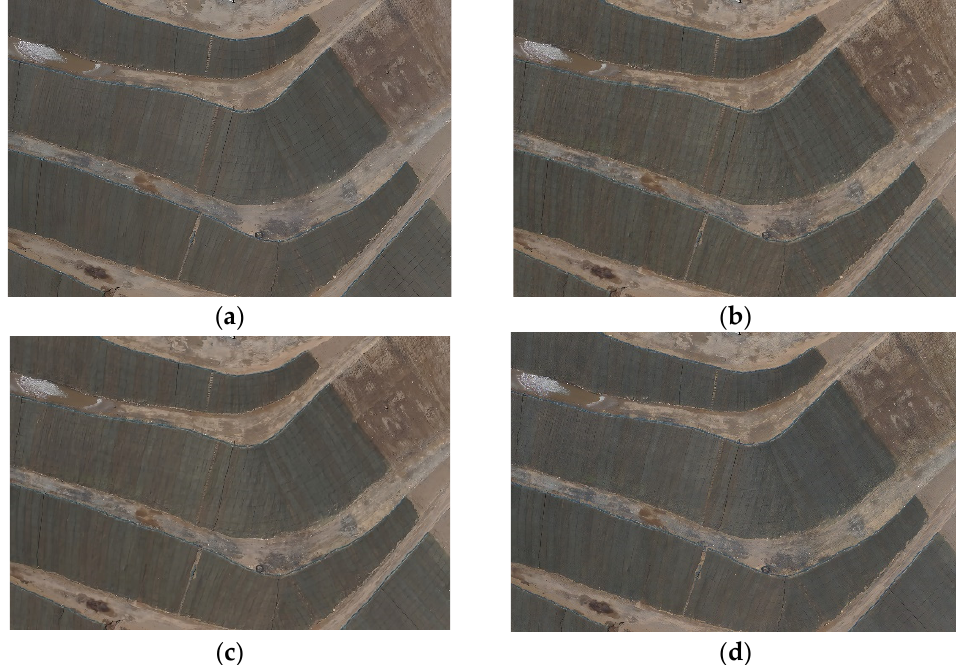
Figure 9. Comparison of concrete cover results ( a ) ESRGAN, ( b ) Real-SR, ( c ) SRMD, ( d ) WAIFU2X.